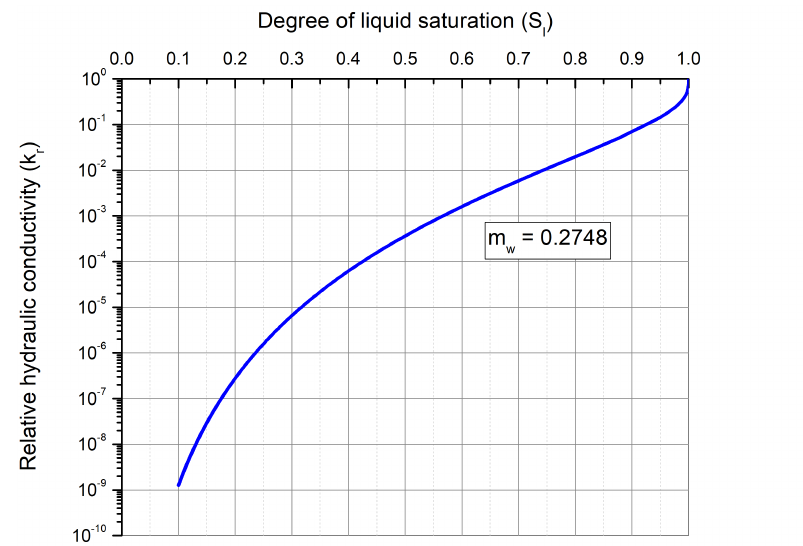
Figure 6. Relative hydraulic conductivity as a function of liquid degree of saturation using Mualem model